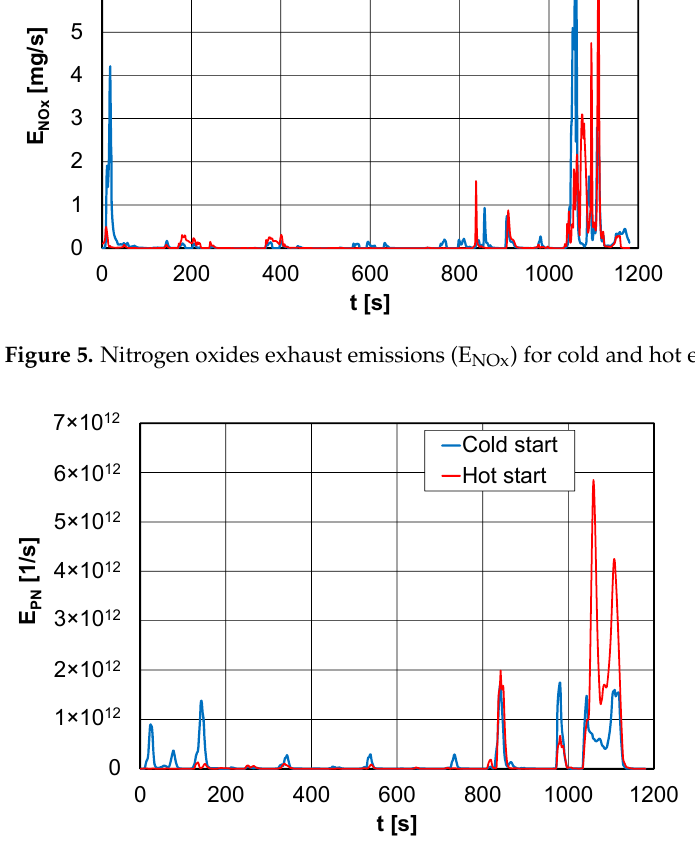
Figure 6. Particle number exhaust emissions (E PN ) for cold and hot engine start.